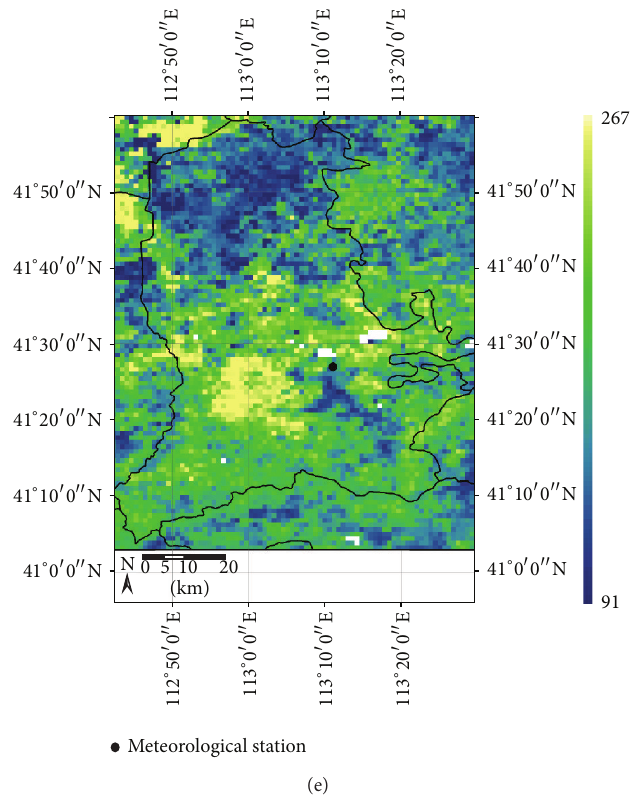
Figure 5: (a) greenup onset, (b) maturity onset, (c) senescence onset, (d) dormancy onset, and (e) the length of vegetation growing season.